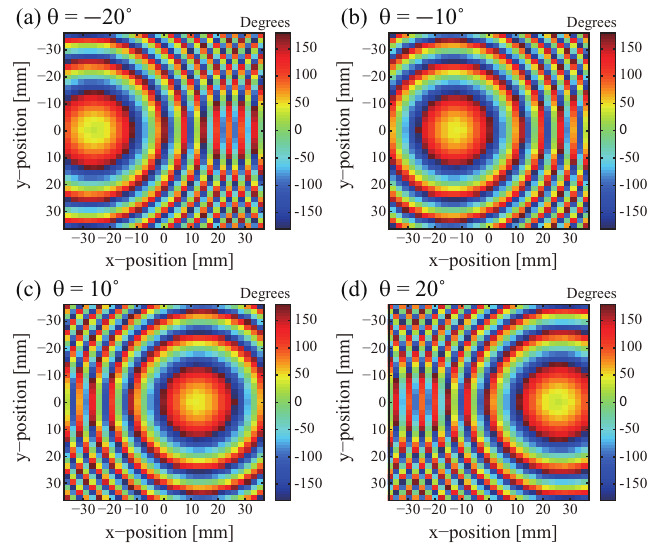
Figure 2. Required phase patterns for reconfigurable millimeter-wave reflectarray antennas from θ = − 20 ◦ to 20 ◦ ( a ) θ = − 20 ◦ ; ( b ) θ = − 10 ◦ ; ( c ) θ = 10 ◦ , ( d ) θ = 20 ◦ .